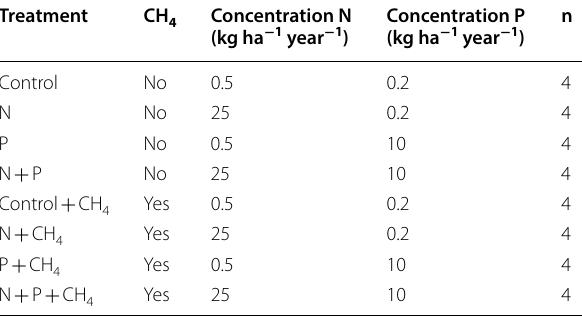
Effects of light/dark were measured in light or dark periods in the climate room